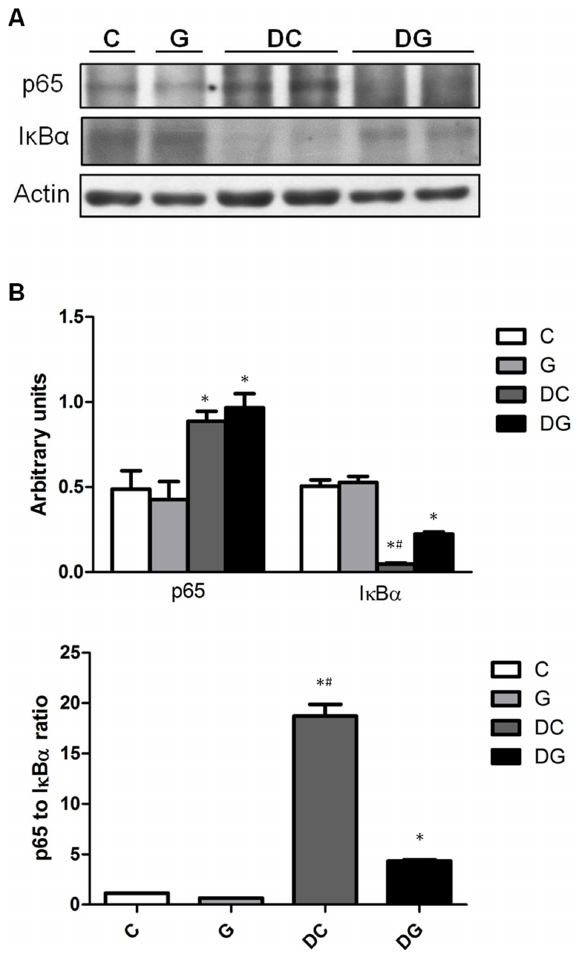
Figure 5. Protein levels of nuclear factor (NF)- k B p65 and inhibitory factor k B a (I k B a ) in colon tissues. a Protein expressions of NF- k B p65 and I k B a . Whole-tissue lysates were analyzed by immunoblotting, and b-actin was used as a loading control. b Densitometric analysis of the blot corrected by the protein loading control. c The ratio of NF- k B p65 to I k B a . Results of the densitometric analysis are shown as the mean 6 SEM. *Significantly differs from the C group. # Significantly differs from the DG group (P , 0.05).